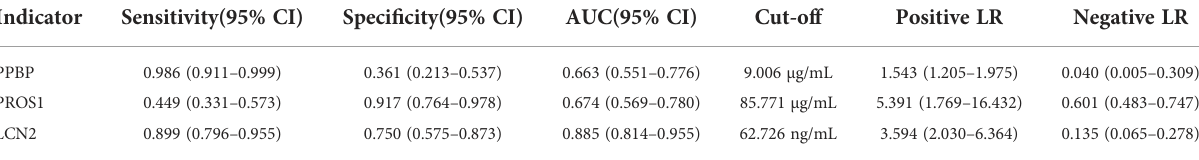
TABLE 5 Receiver operating characteristic (ROC) of PPBP, PROS1, and LCN2 for prediction of Parkinson ’ s disease and healthy controls.